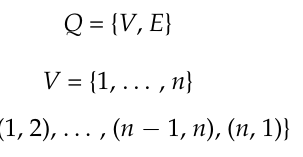
Table 1. Abbreviations and symbols are used in this